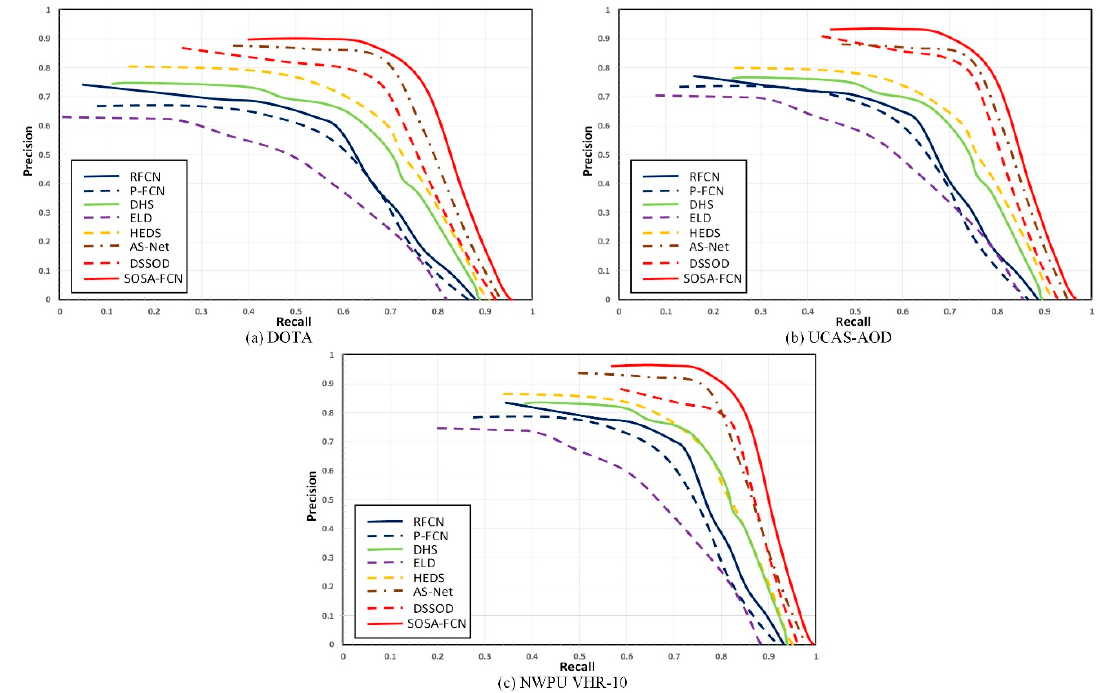
Figure 5. SOD results with precision and recall (P-R)-curve using three datasets.